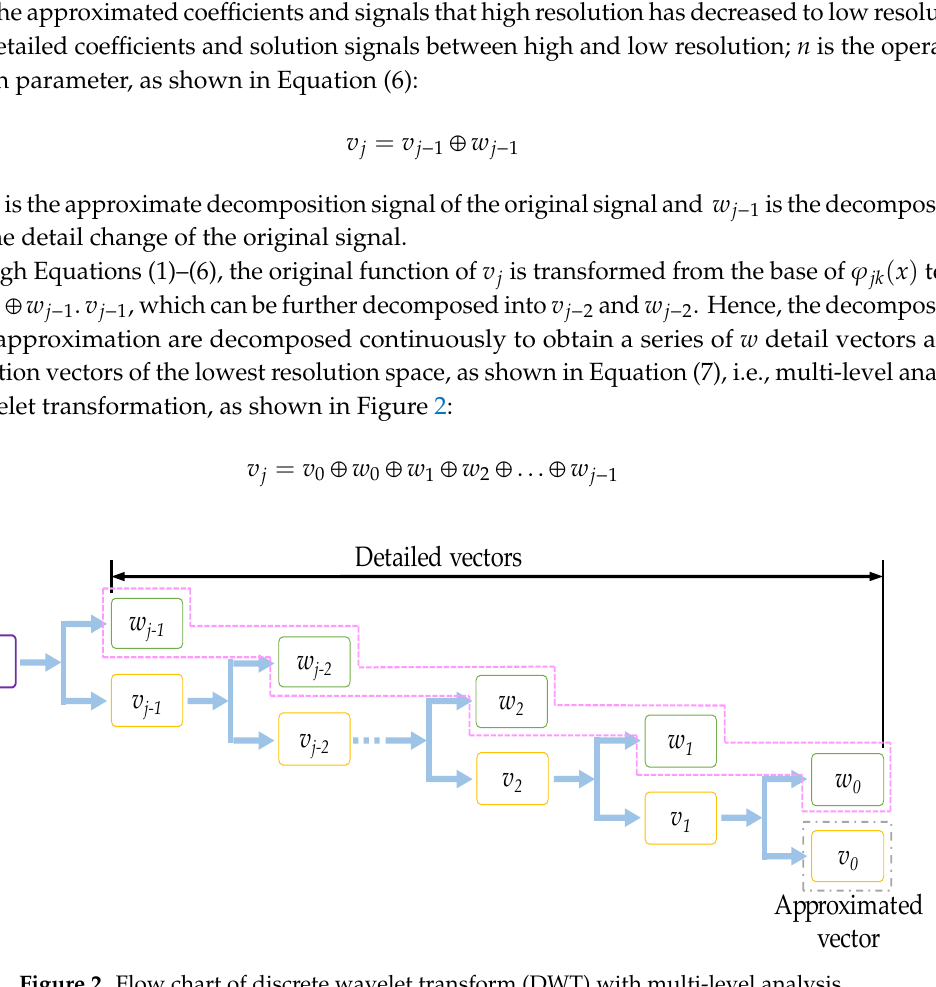
Figure 2: Flow chart of discrete wavelet transform (DWT) with multi-level analysis. 139 Figure 2. Flow chart of discrete wavelet transform (DWT) with multi-level